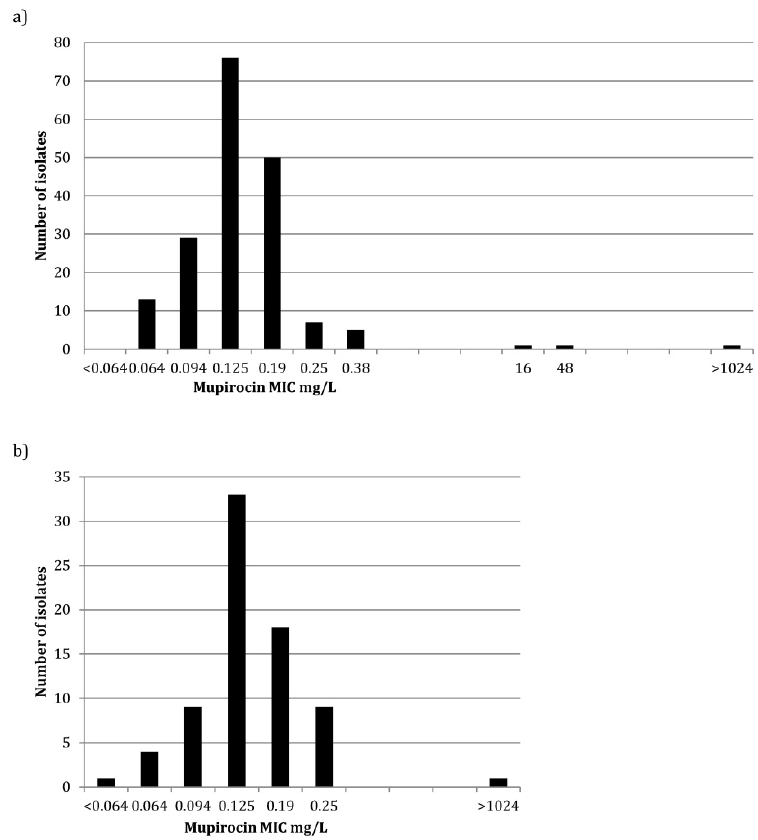
Figure 1. Distribution of minimum inhibitory concentrations (MICs) of mupirocin among S. epidermidis isolates obtained from prosthetic joint infections (a) and from nares (b). The breakpoints for nasal decolonization of S. aureus according to NordicAST (http://www.nordicast.org) is S ≤1 mg/L and R >256 mg/L,